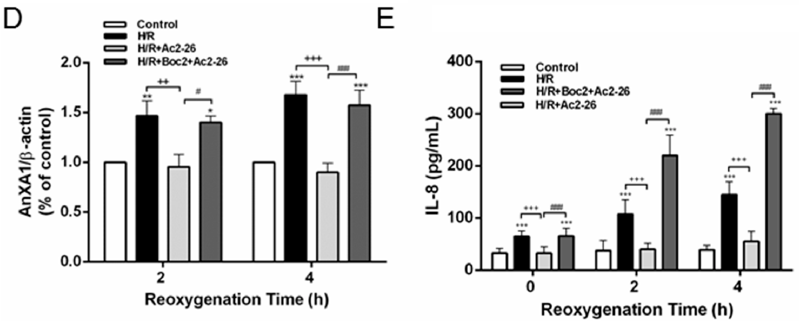
Figure 10. Effect of Ac2-26 and Boc2 in A549 cells subjected to hypoxia-reoxygenation (H/R). Ac2-26 significantly attenuated increased AnxA1 protein expression induced by H/R in A549 cells ( A ). Ac2-26 significantly reduced the increase of phosphorylated NF- κ B p65 in the nucleolus, degradation of I κ B- α ( A ), and IL-8 production at 2 and 4 h in A549 cells exposed to H/R ( E ). The addition of Boc2 blocked the effect of Ac2-26. A representative blot is shown ( B – D ). Lamin B1 served as loading control for nuclear protein. Data are expressed as means ± SD ( n = 6). * p < 0.05, ** p < 0.01, *** p < 0.001 compared with the control group; ++ p < 0.05, +++ p < 0.001, compared with the H/R group; and # p < 0.05, ### p < 0.001, compared with the H/R + Ac2-26 group.